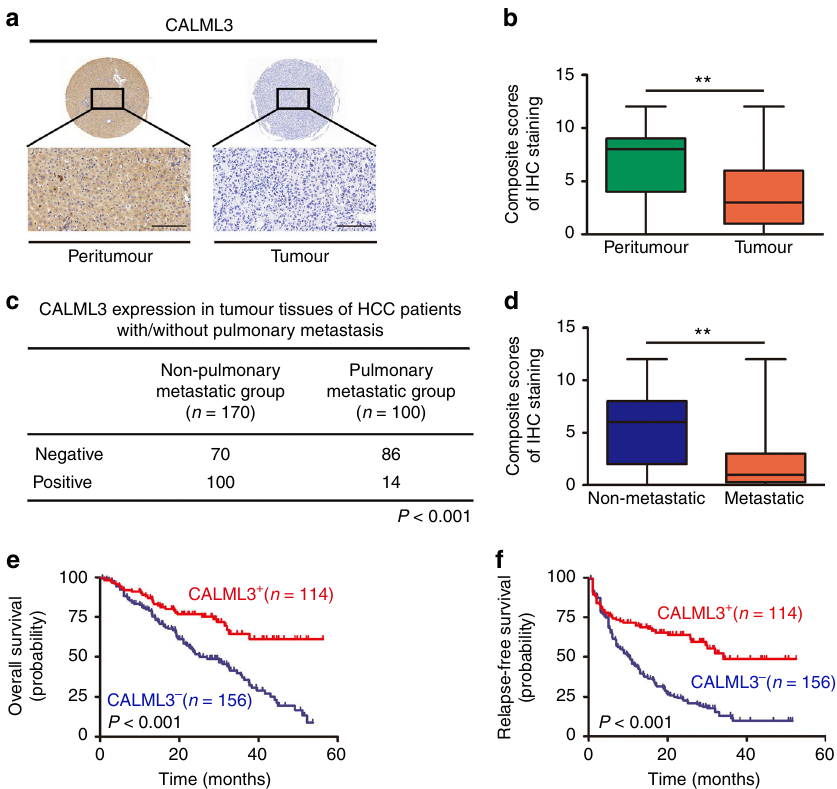
Fig. 6 CALML3 analysis by immunostaining in tumour tissue slices from patients. a Histological images of tissue specimens from HCC patients show different patterns of CALML3 staining (scale bar, 50 μ m). CALML3 staining was primarily in the cytoplasm. b Scores of immunochemistry staining of CALML3 in 270 pairs of tumour tissues and peritumour tissues. The horizontal lines in the box plot (minimum to maximum) represent the median and the interquartile ranges. Error bars represent mean ± SD. IHC scores were compared by Student ’ s t -test, ** P < 0.01. c The intratumoural CALML3 expression was signi fi cantly lower in the pulmonary metastatic group than that in the non-metastatic group ( P < 0.001). d Scores of immunochemistry staining of CALML3 in tumours tissues of 100 patients with pulmonary metastasis and 170 patients without pulmonary metastasis. The horizontal lines in the box plot (minimum to maximum) represent the median and the interquartile ranges. Error bars represent mean ± SD. IHC scores were compared by Student ’ s t - test, ** P < 0.01. e , f Kaplan – Meier analysis showed that intratumoural CALML3 expression was a protective factor related to overall survival ( P < 0.001) ( e ) and relapse-free survival ( P < 0.001) ( f ). P -value is determined by log-rank